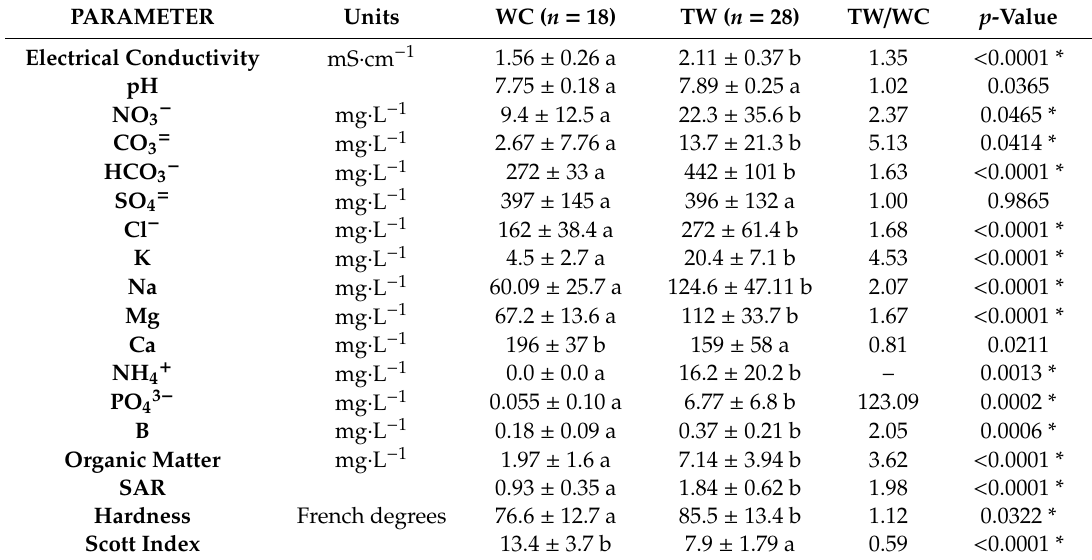
Table 5. Control water versus treated wastewater.